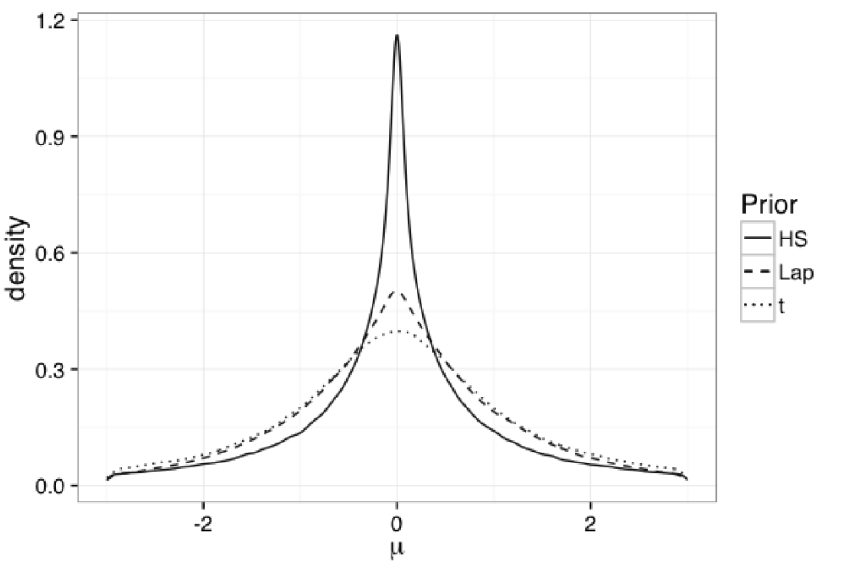
Figure 1. Densities of the implied prior on µ j based on the horseshoe prior, the t prior, and the Laplacian